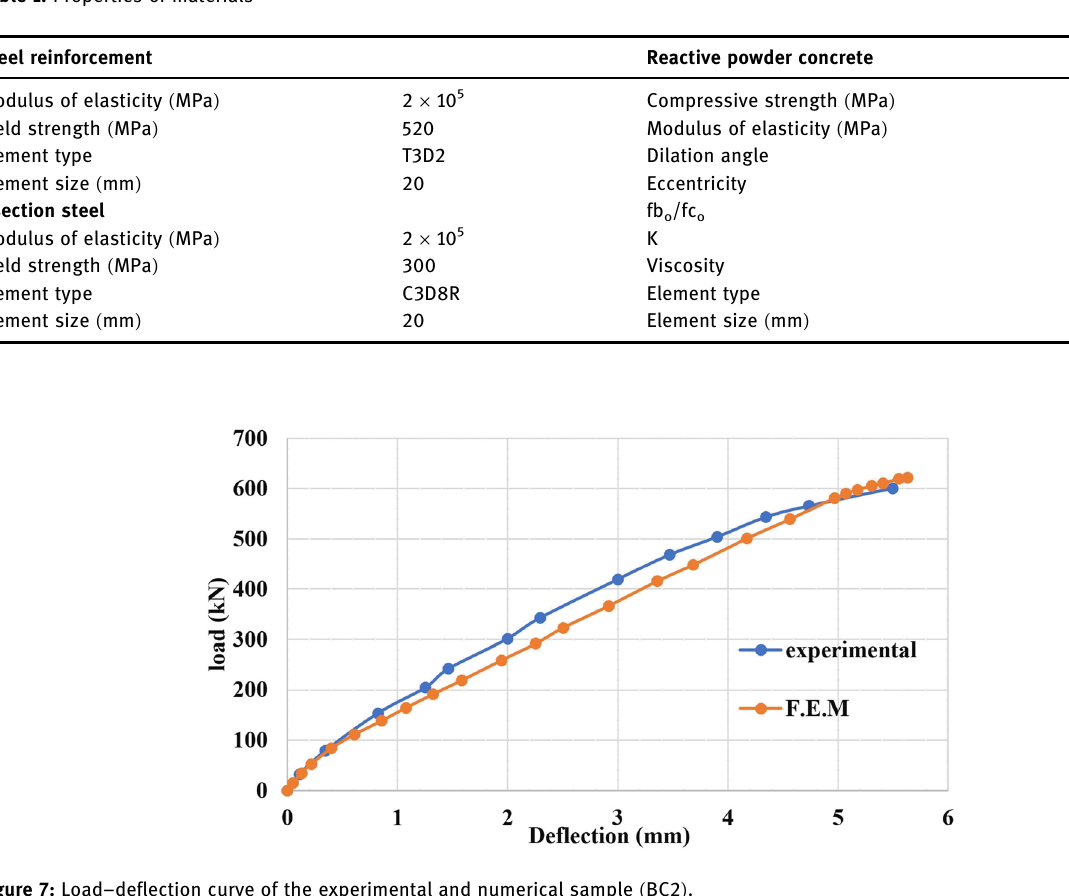
Table 1: Properties of materials